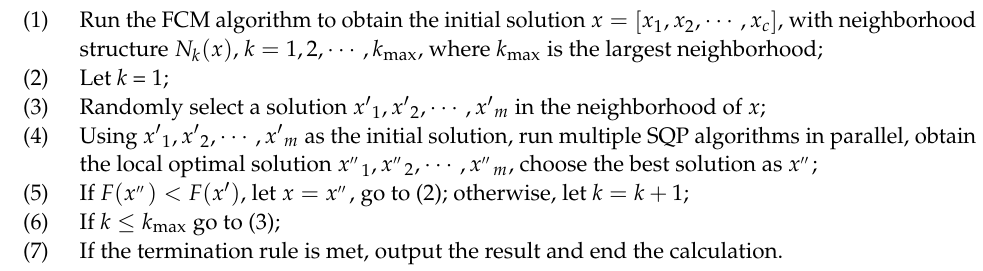
Algorithm 1. Algorithm